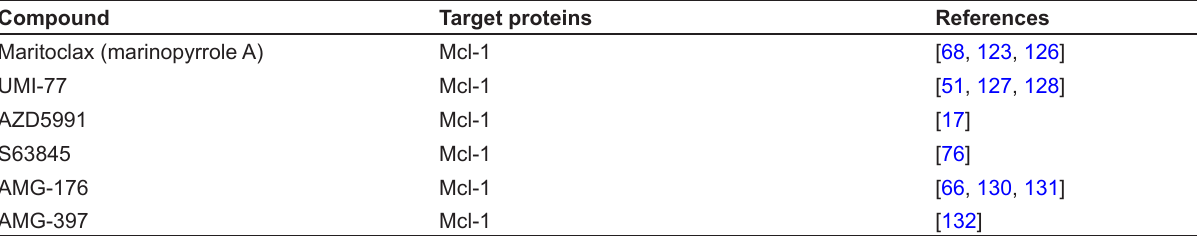
Table 2. List of select pan-Bcl-2 or Mcl-1 specific inhibitors ( continued ) Compound Target